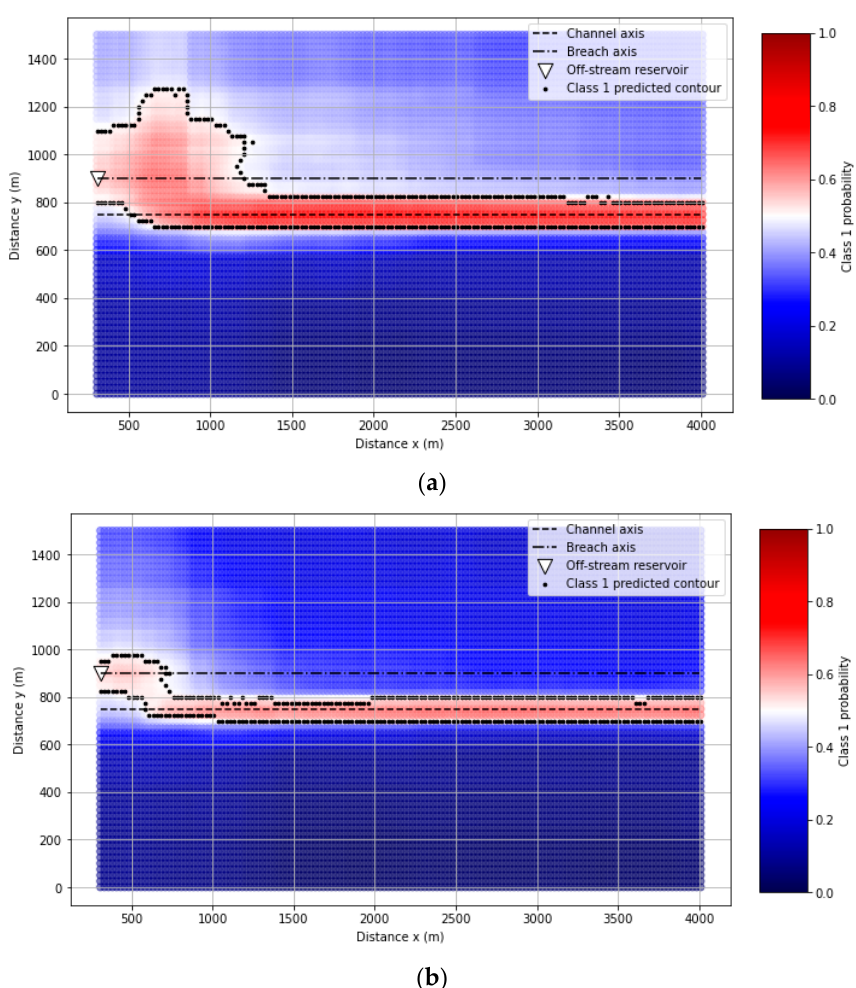
Figure 8. Probability maps Class 1: ( a ) synthetic case 001V (Manning coefficient: 0.02 s/m 1/3 ); ( b ) synthetic case 001V (Manning coefficient: 0.12 s/m 1/3 ).